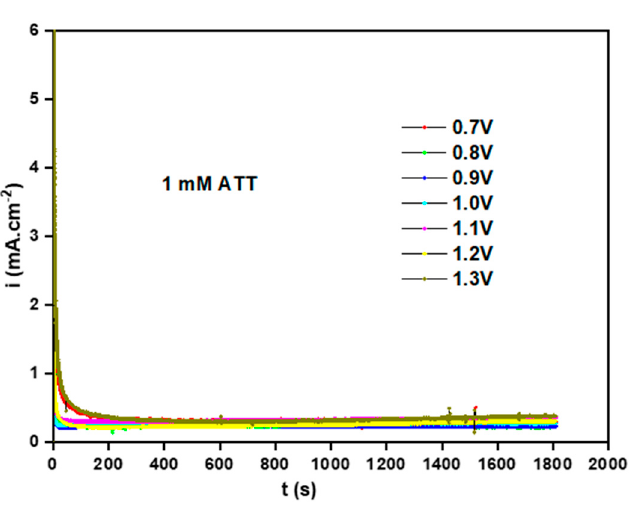
Figure 4. Chronoamperometry curves obtained at different potentials before and after the ATT oxidation peak potential.